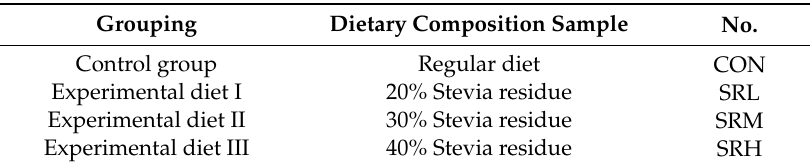
Table 1. Test grouping.